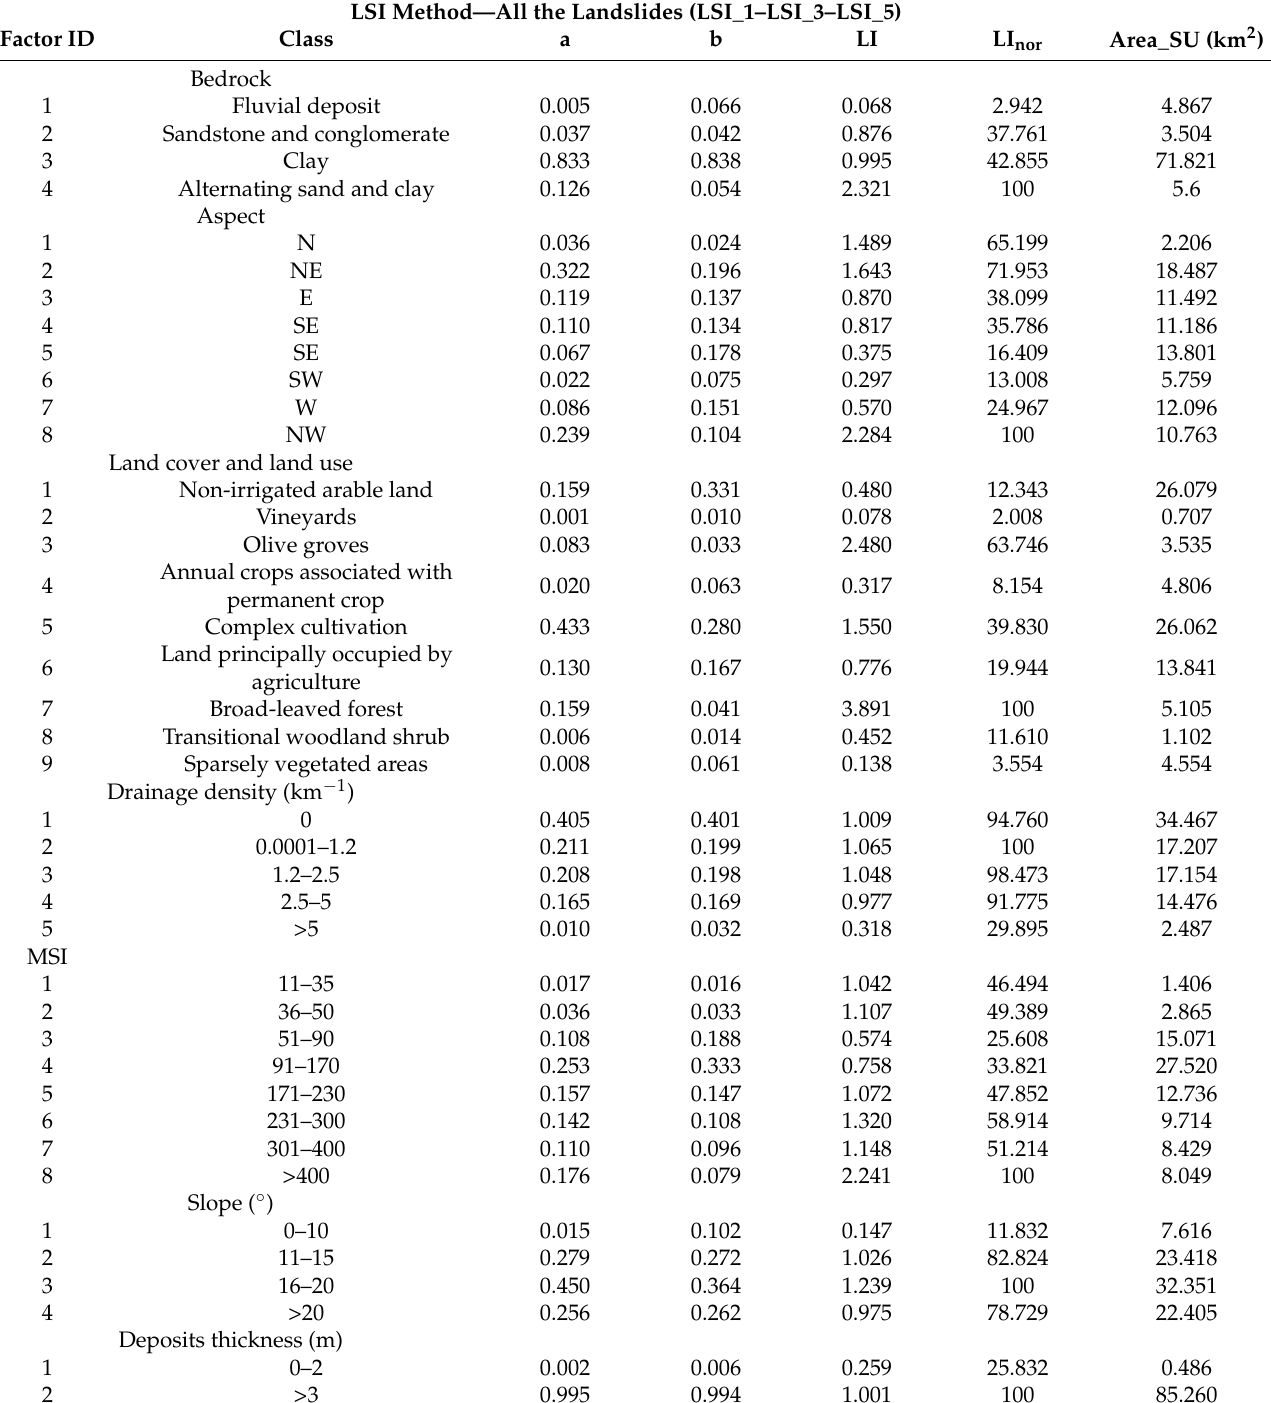
Table A1. Values of the parameters for deriving the LSI for the models